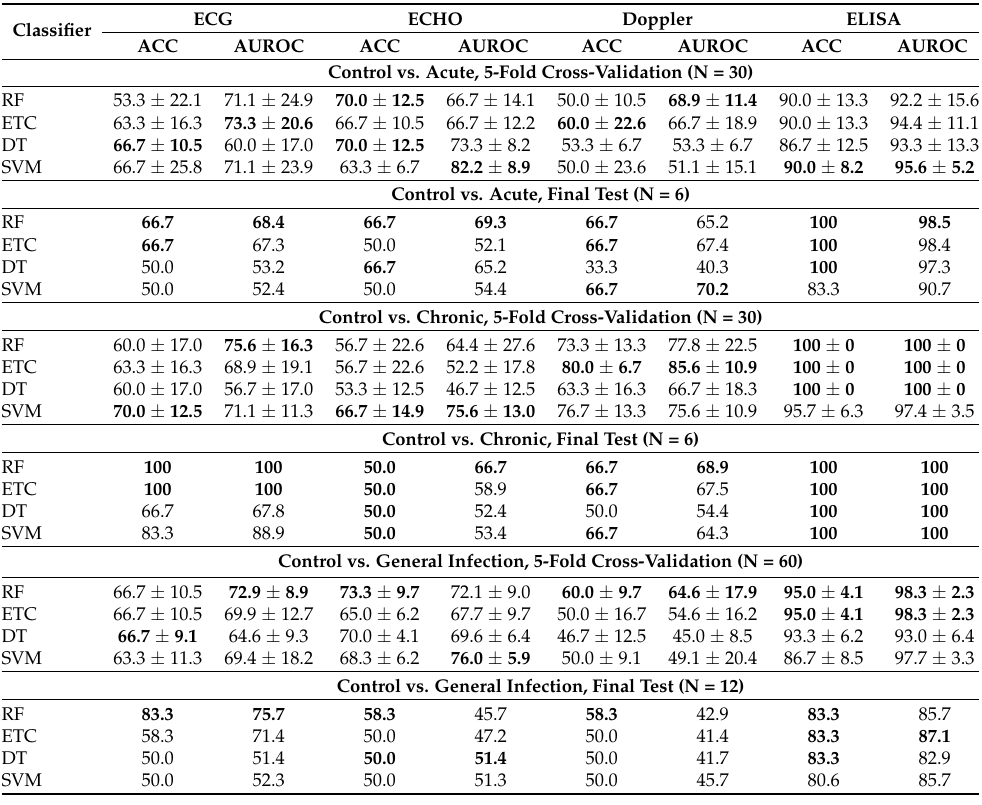
Table 2. Classification performance (%) for each modality: ECG, ECHO, Doppler and ELISA. Cross- validation results are expressed as mean and standard deviation. The best performances are presented in